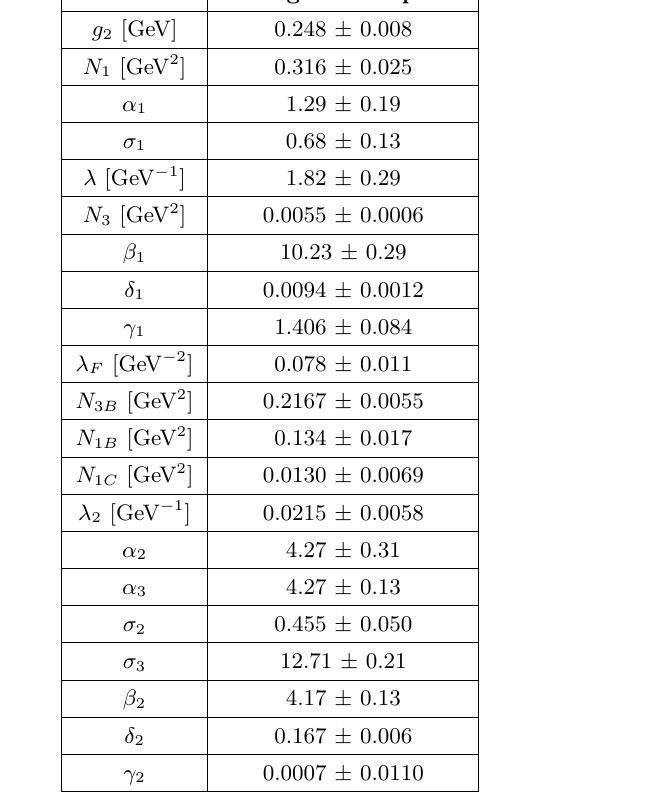
Table 5 . Average and standard deviation over the Monte Carlo replicas of the free parameters fitted to the